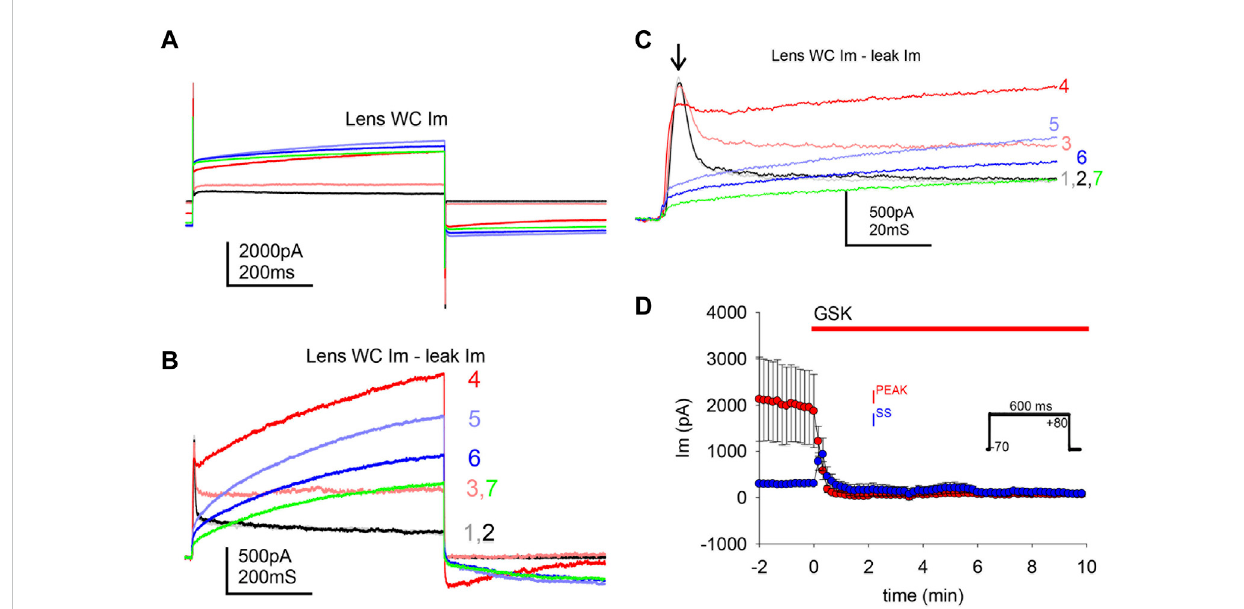
FIGURE 5 TRPV4 agonist GSK1016790A abolished a transient outward current. TRPV4 agonist GSK1016790A caused an increase of the whole cell gm, and a decrease of outward ionic currents. (A) Illustration of the large WC Im increase induced by TRPV4 activation while applying square pulses (inset in D). (B – C) Ionic outward currents evinced by subtraction of putative leak current from traces in A (color coded to indicate correspondence to the traces in A and numbered to indicate pulse order every 10 s); a closer look of the transient I peak is shown in C (arrow). GSK1016790A was applied at the second pulse. (D) Average of transient peak (I peak , maximum) and steady state (I ss , last 100 ms) outward currents, during GSK application ( n =